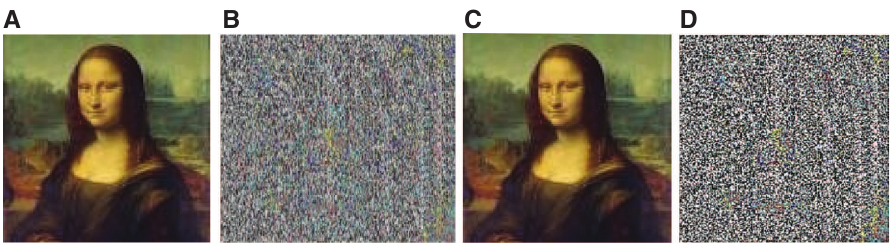
Figure 10: Results of Sensitivity Test. (A) Original image of “Mona Lisa”. (B) The encrypted image of (A). (C) The decrypted image of (A) with the correct key. (D) The decrypted image of (A) with a change in key z 0 ( z 0 =